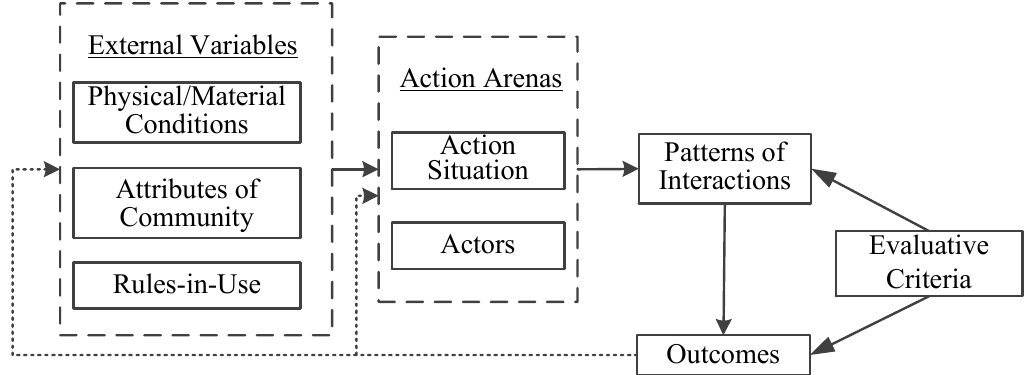
Figure 1. Conceptual analytical framework [45].